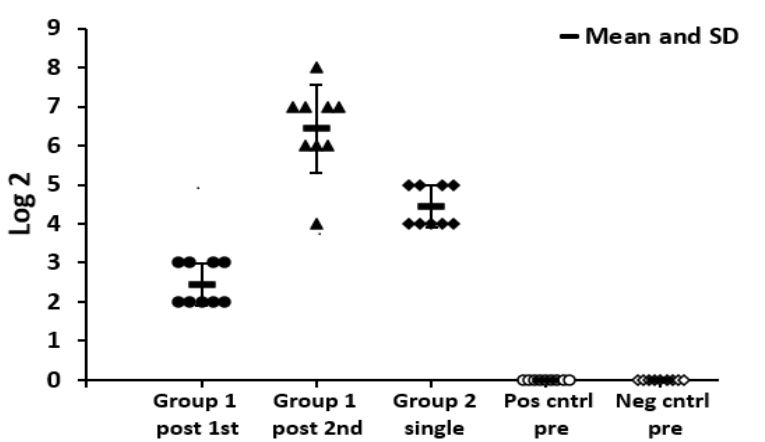
Figure 2. Chart for displaying the individual HI titers in log 2 after injection of the prepared VLPs without adjuvant. The chart shows the immune response of chickens in group-1 at 3-weeks after the injection of the first dose (Group1 post 1st), 3-weeks after second dose (Group1 post 2nd), and the immune response after 3 weeks by the injection of the single dose in group 2 (Group 2 single). Moreover, the positive control group pre-challenge (Pos cntrl pre) and negative control group pre-challenge (Neg cntrl pre). The figur shows the standard deviation (SD) and mean. Survival Plot